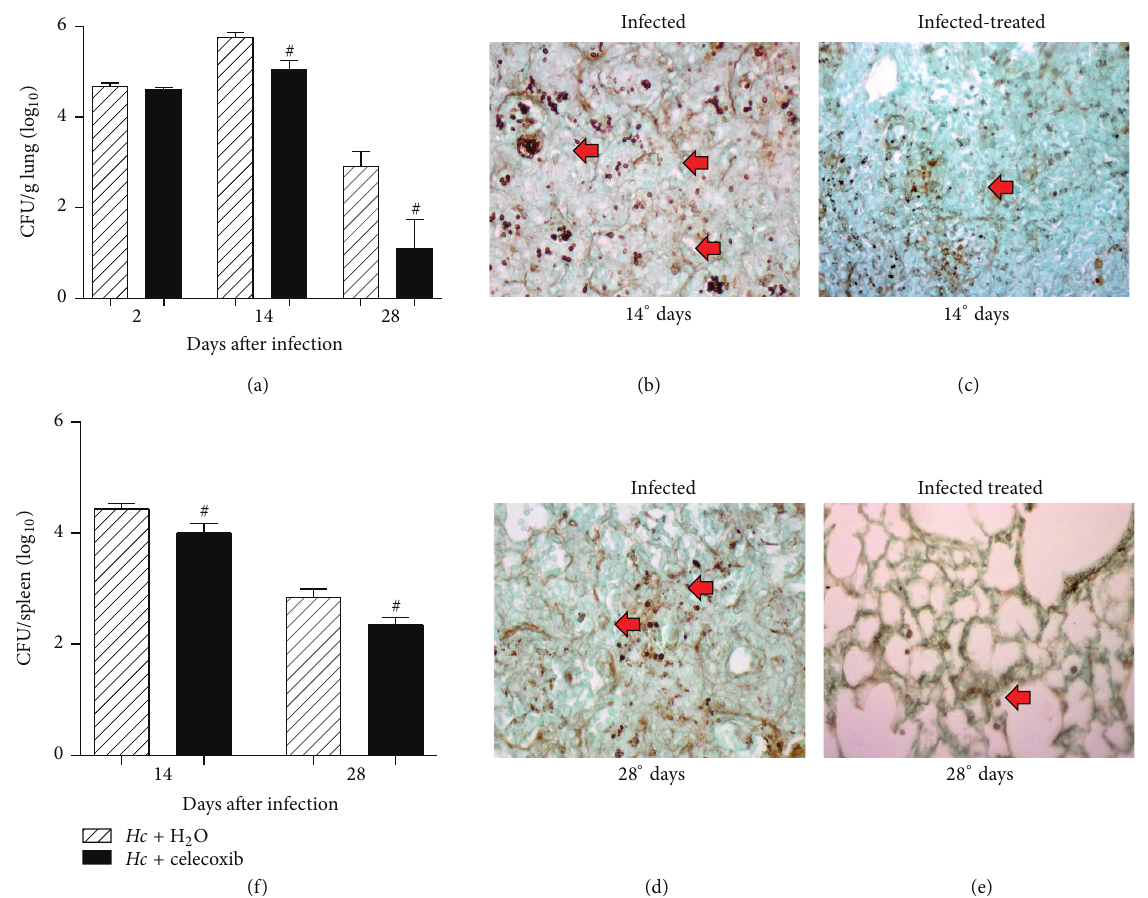
Figure 1: Celecoxib reduces the fungal burden in the lungs and spleen of H. capsulatum -infected mice. The fungal burden in the lungs (a) and spleen (f). Tissue samples were harvested at 2, 14, or 28 days after the sublethal inoculation of H. capsulatum . At 14 (b, c) and 28 (d, e) days after infection, the lung sections from mice receiving daily water (b, d) or celecoxib treatment (c, e) were stained with Grocott’s methenamine silver (GMS) to detect yeast cells (black arrow shows the H. capsulatum yeast). Original magnification: 360x. The data are presented as the means ± SEM representative of three independent experiments (𝑛 = 5 - 6) . One-way ANOVA (Tukey’s multiple comparison test) was used. # Hc + H 𝑃 < 0.05 2 O versus Hc + celecoxib